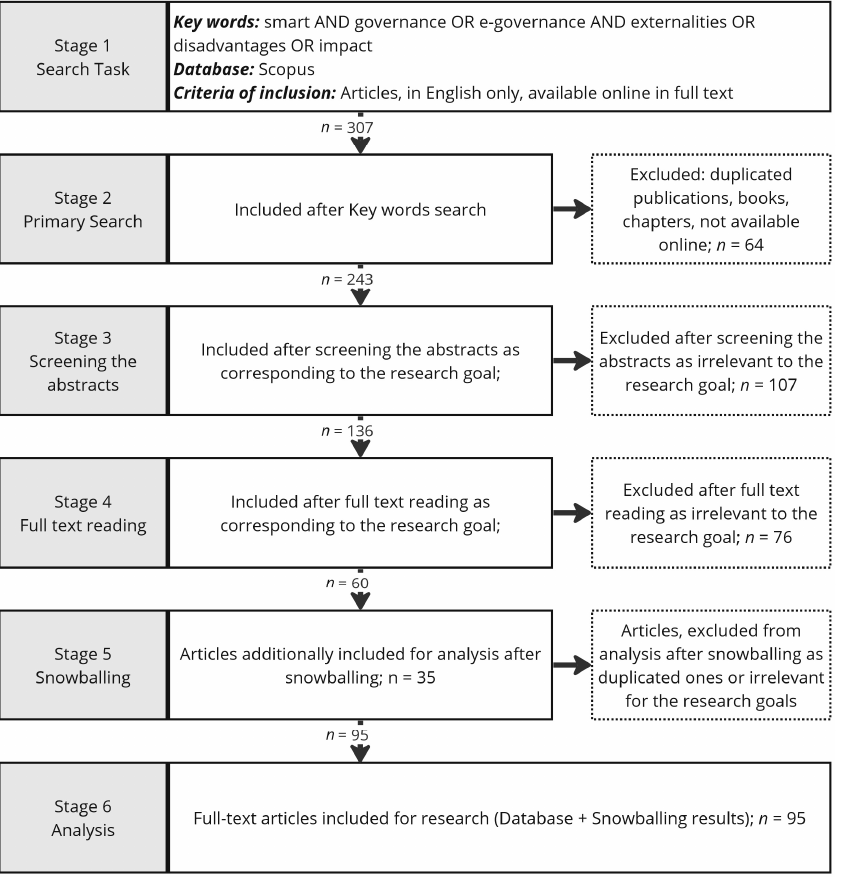
Figure 2. Procedure of selecting the articles on effects and externalities for qualitative analysis. Source: generated by the authors.